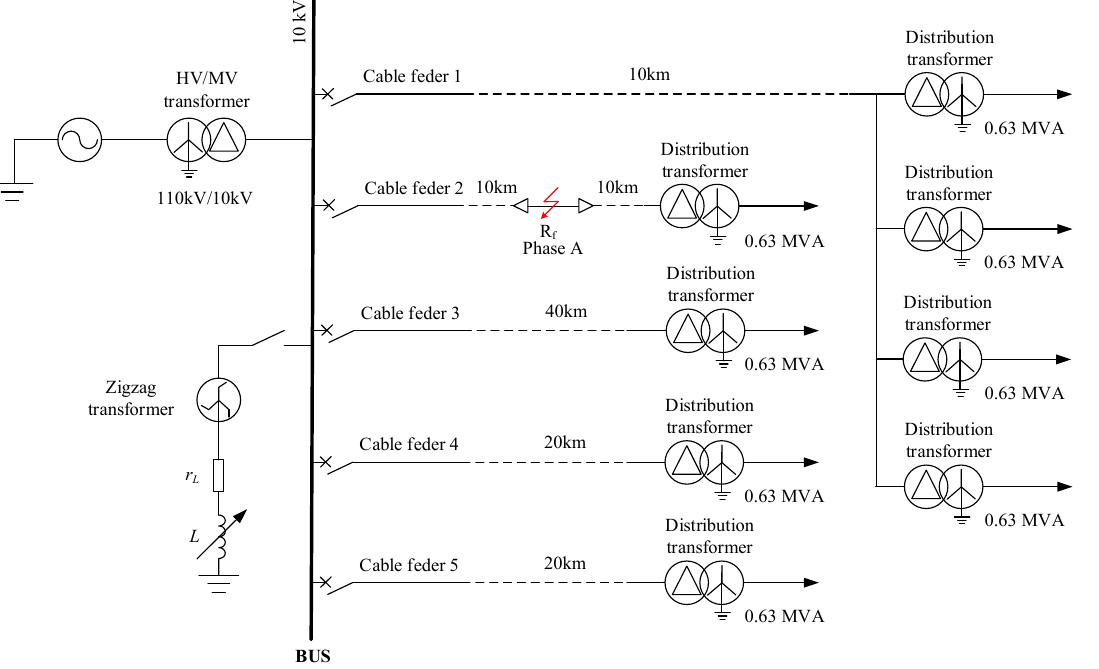
Figure 8. Simulation model of the resonant grounded distribution.